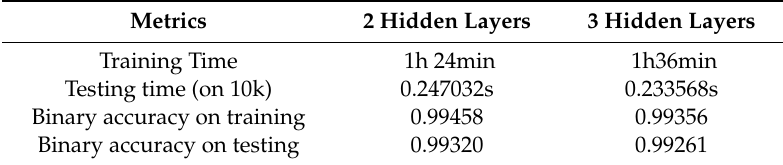
Table 3. Results of the comparison between different number of layers.